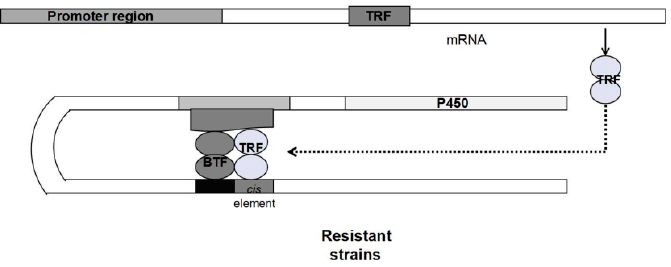
Figure 2. A speculative model of P450 gene regulating insecticide resistance in resistant strains. The interaction of P450 gene in resistant strains with basic transcription factor (BTF) and cis -acting element( cis - element) or trans -regulatory factor (TRF) in insecticide resistance [97].